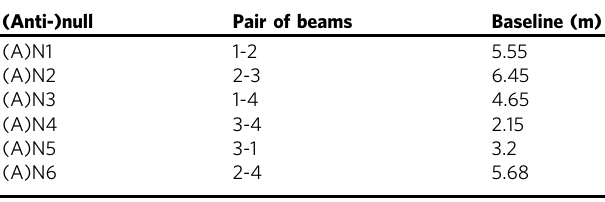
Table 1 Identi fi cation table cross-referencing the nulled and anti-nulled outputs with the corresponding pair of beams together with the length of the baseline on